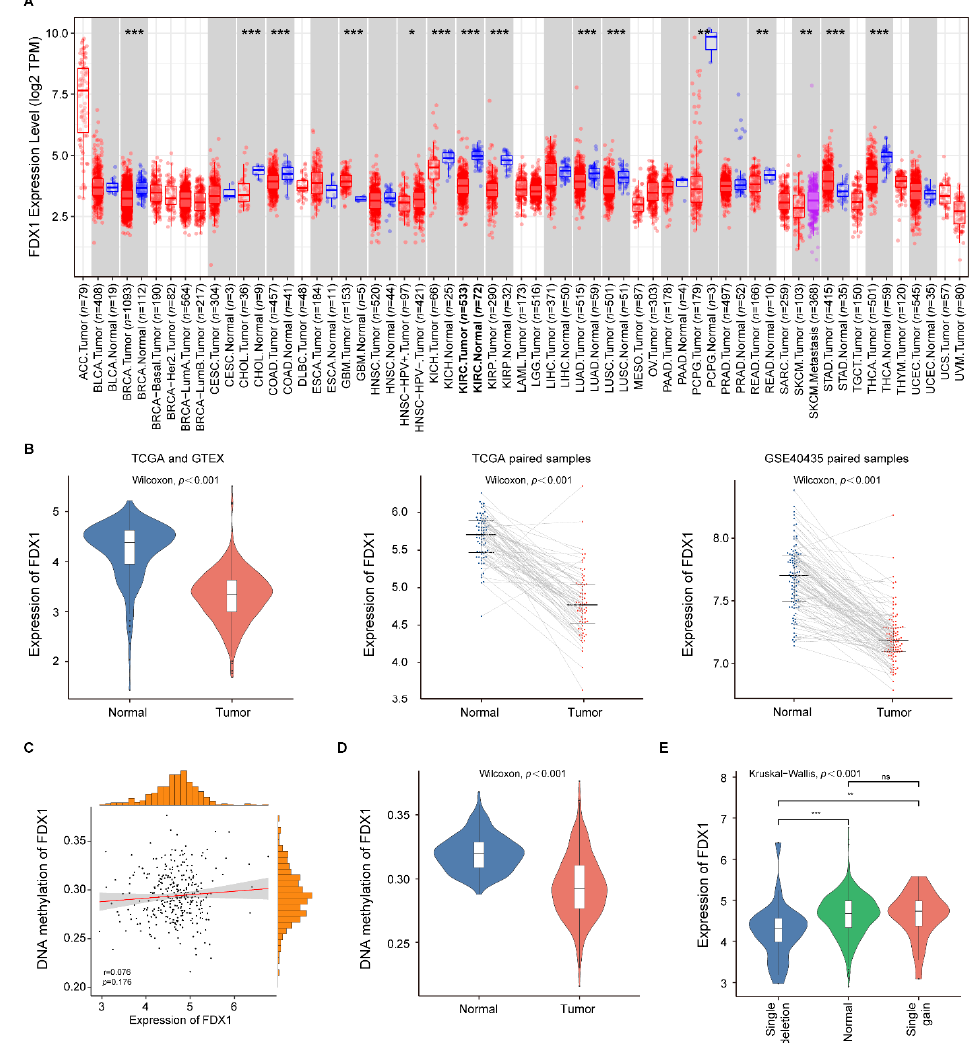
Figure 2. FDX1 expression in pan-cancers and ccRCC patients. ( A ) The expression of FDX1 in different tumor samples compared with normal samples; ( B ) FDX1 expression was significantly decreased in ccRCC samples compared with normal renal samples in TCGA, GTEx, and GSE40435 cohorts; ( C ) Correlation analysis of FDX1 gene methylation and expression levels; ( D ) The methyla- tion level of FDX1 in the ccRCC samples was significantly lower than in the adjacent normal samples; ( E ) Expression patterns of FDX1 among different CNV groups. p values less than 0.05 were consid- ered to be statistically significant and ns represents no significant differences. * p < 0.05, ** p < 0.01, *** p <